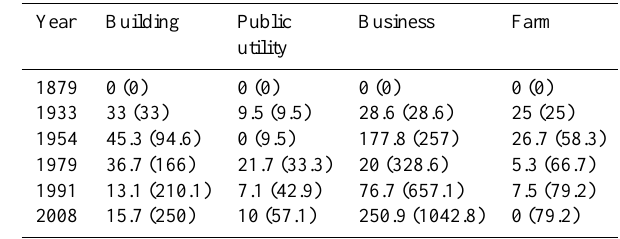
Table 3. Categories and built-up areas in the city of Savigliano in each investigated year. In the last column, the total occupied area, in brackets the increased area in square kilometres compared with the previous year. Numbers are in square kilometres and measurements done by GIS.